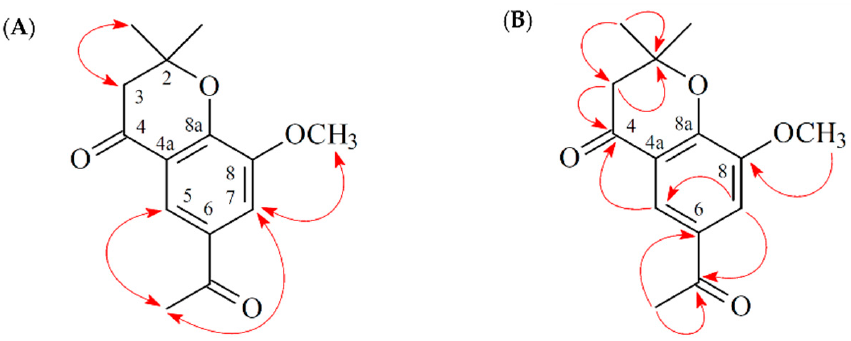
Figure 4. Key 1D-selective NOESY ( A ) and HMBC ( B ) correlations of 3 . Table 2. 1 H and 13 C NMR data of 3 .